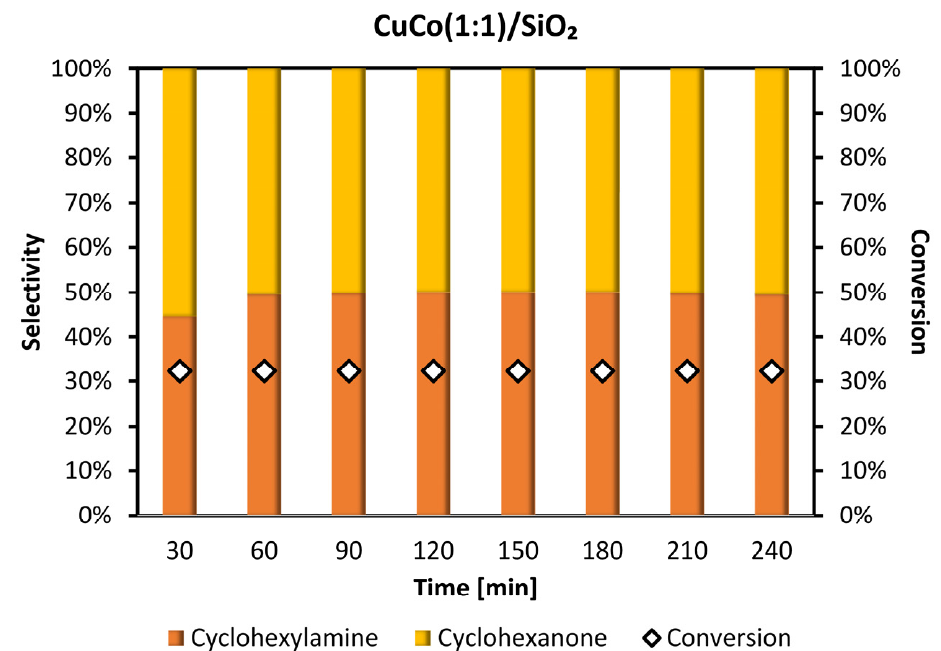
Figure 17. Catalytic hydrogenation of nitrocyclohexane in gas flow conditions with CuCo(1:1)/SiO 2 .